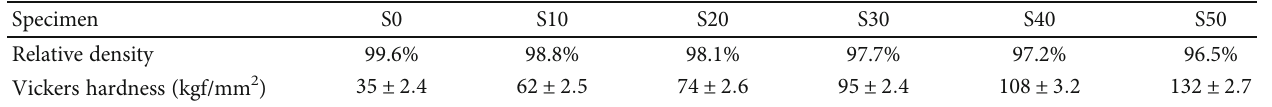
Table 2: Vickers hardness and relative density of the SiC